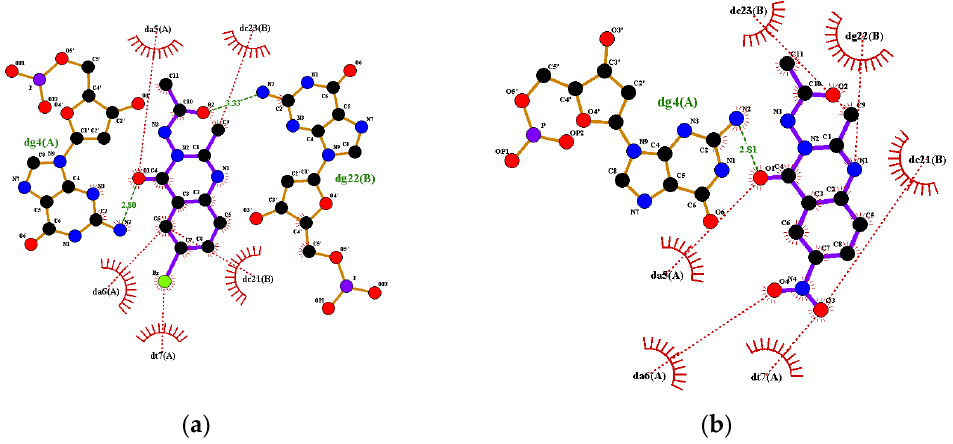
Figure 9. Panel ( a ): 2D Molecular Interactions for compound 6 ; Panel ( b ): 2D Molecular Interactions for compound 8 .